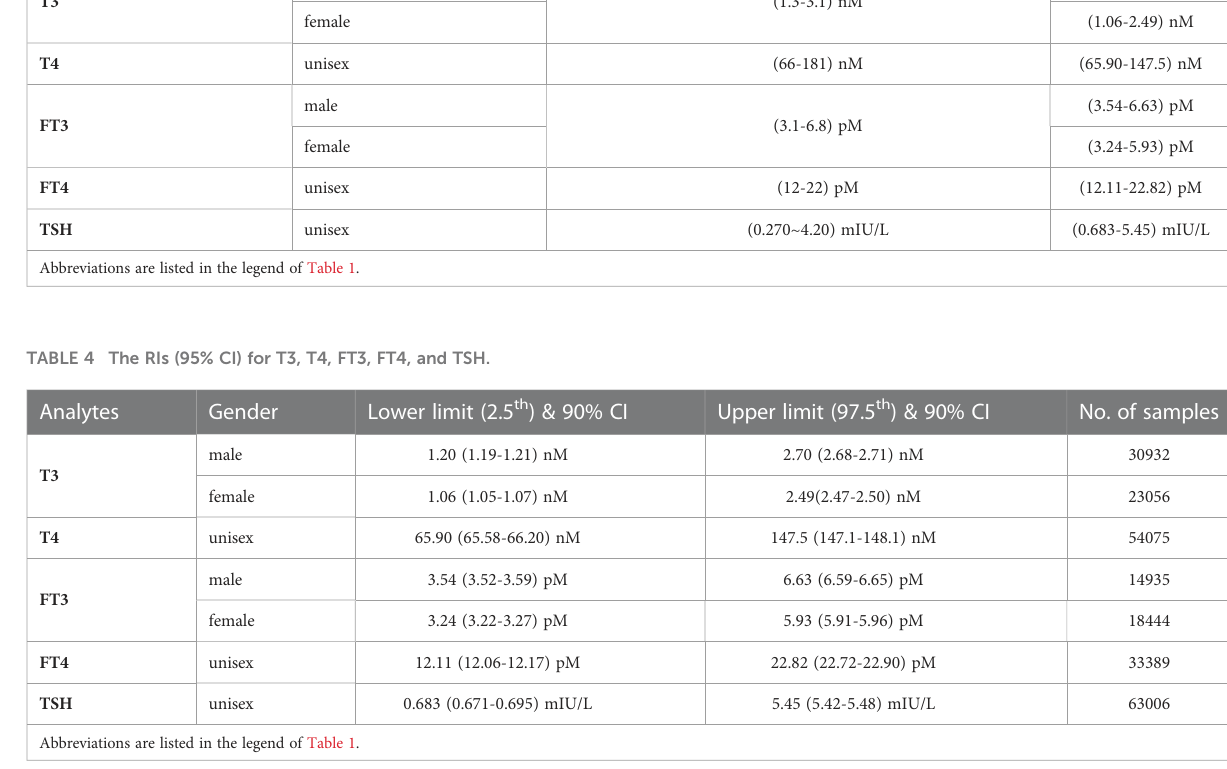
Abbreviations are listed in the legend of Table